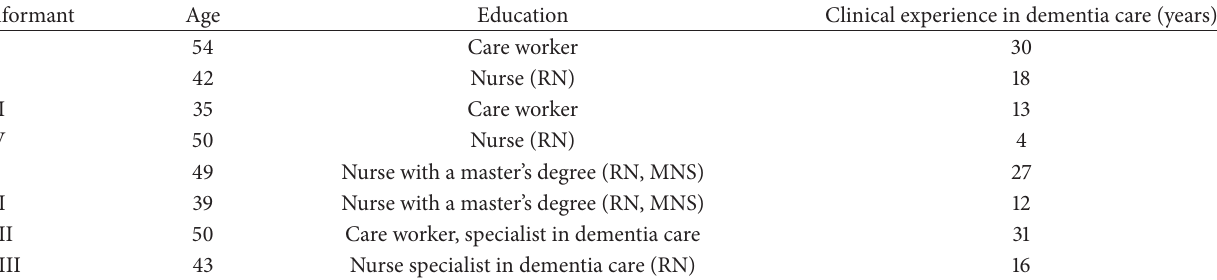
Table 1: Characteristics of the informants participating in